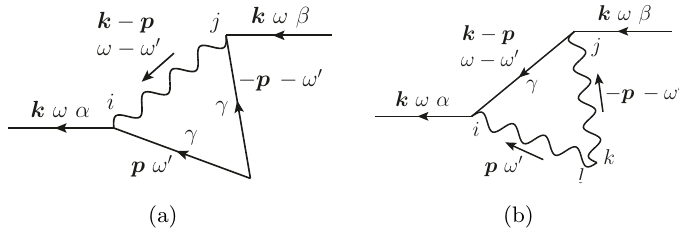
Figure 7 . Diagrams for (cid:6)